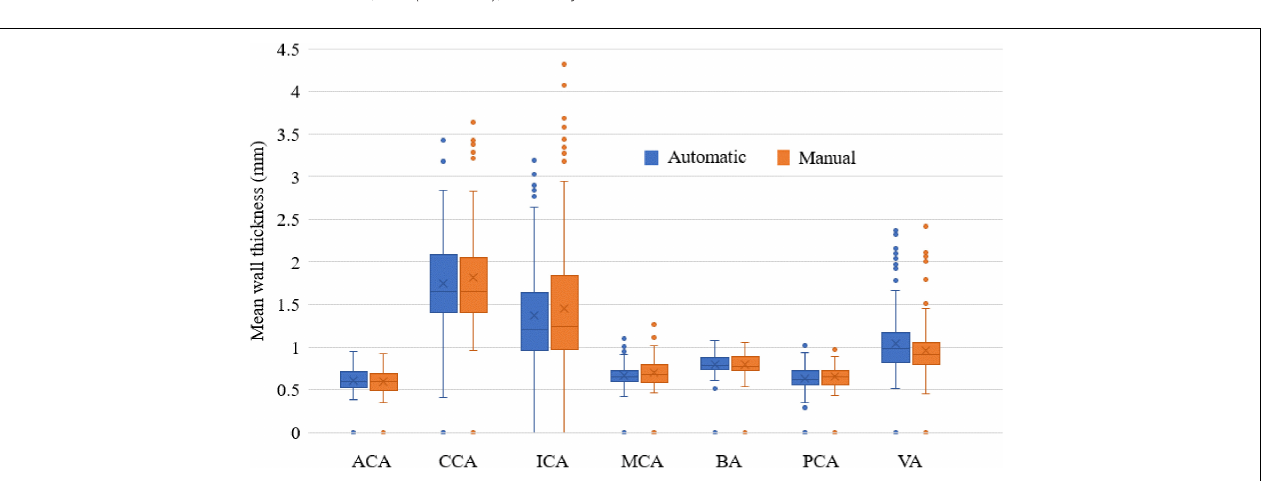
and their manual segmentations for reference. All the DSC values were greater than 80%, especially for lumen contour detection, and the DSC values were all greater than 83.9%. The lowest DSC value for the lumen contour was 92.3% of the PCA, and the highest DSC value was 94.7% of the CCA. For the outer wall contour, the lowest and highest DSC values were 83.9% of the PCA and 88.3% of the CCA. In general, a DSC higher than 70.0%